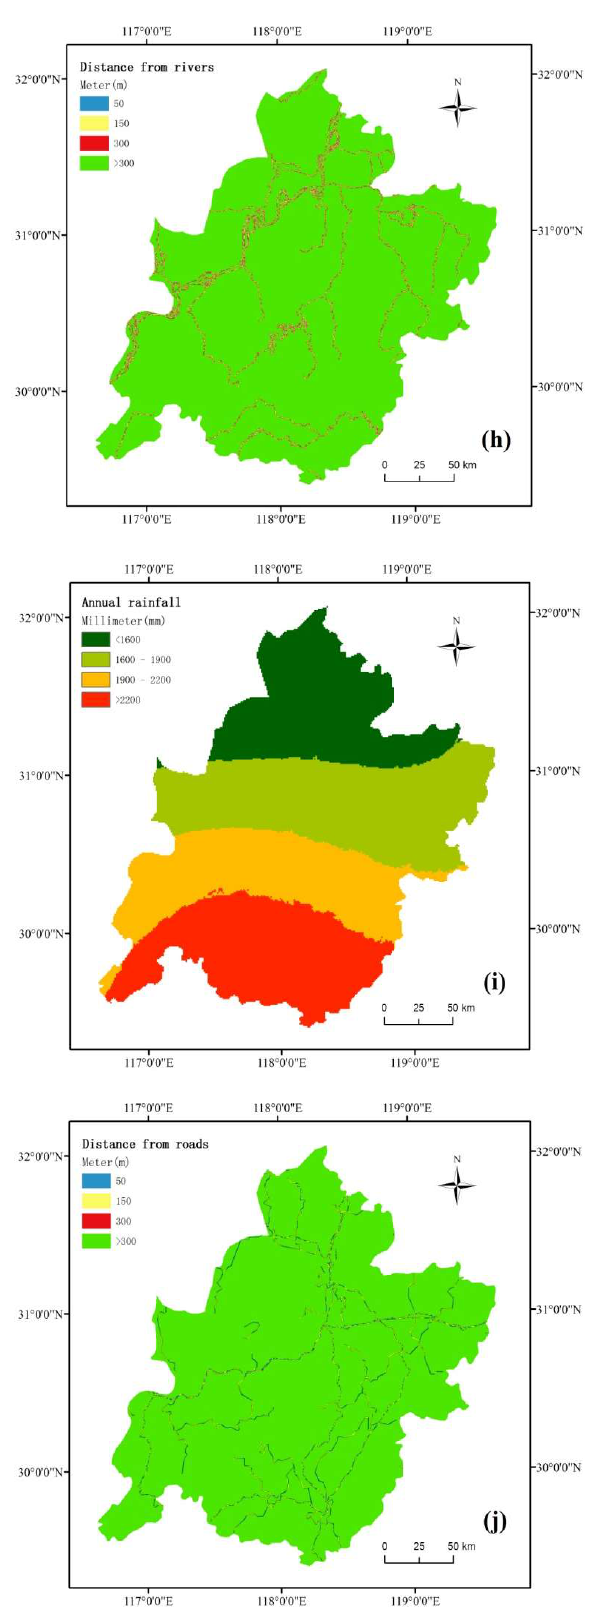
Figure 4. Classification of information contents of the landslide-a ff ecting factors: ( a ) lithology, ( b ) distance from faults, ( c ) NDVI, ( d ) elevation, ( e ) slope, ( f ) aspect, ( g ) profile curvature, ( h ) distance from rivers, ( i ) annual rainfall, ( j ) distance from